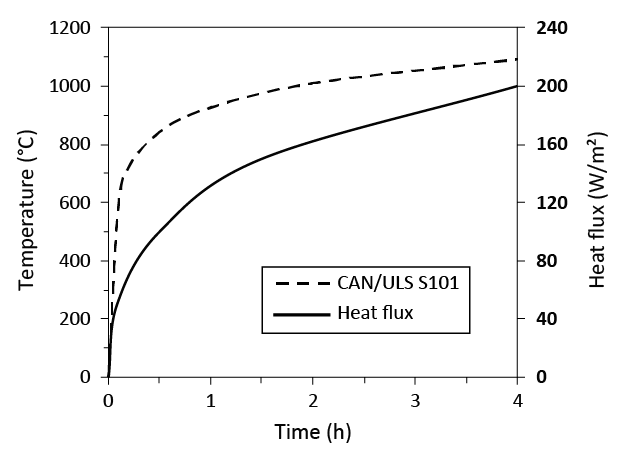
Figure 11. CAN / ULC S101 standard fire curve and corresponding heat flux. Figure 11. CAN/ULC S101 standard fire curve and corresponding heat flux. Table 1. Heat flux